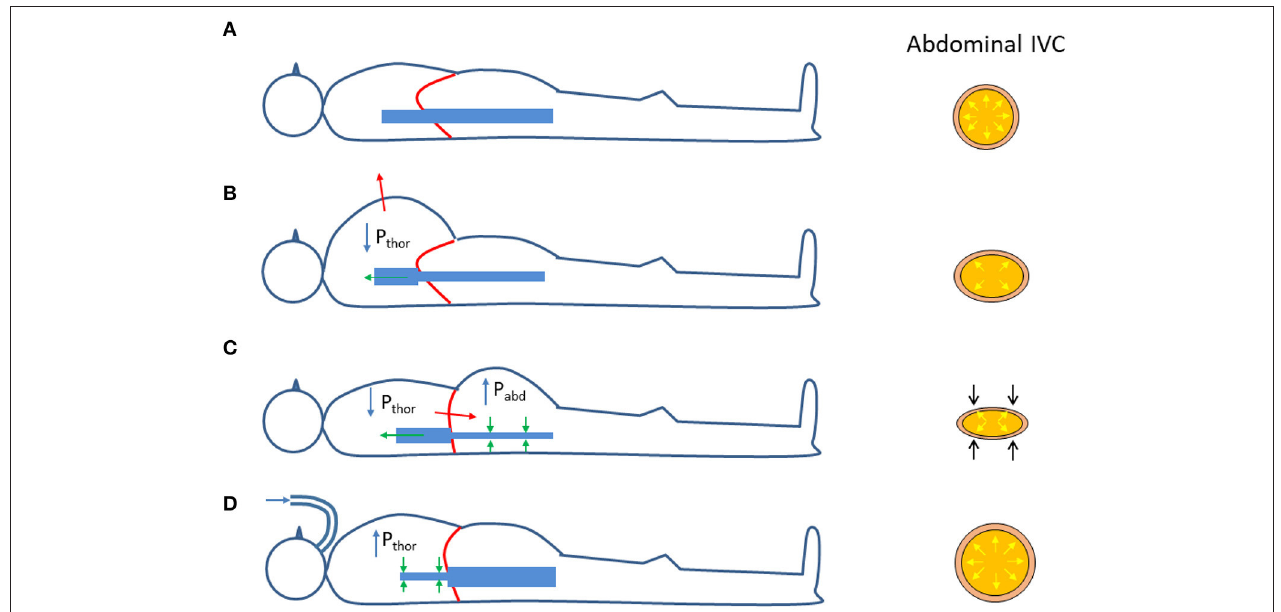
FIGURE 2 | Effects of respiration on the size of the abdominal inferior vena cava (IVC); see explanation in the text. P thor = Intrathoracic pressure; P abd = abdominal pressure. (A) Functional residual capacity (end expiration). (B) Thoracic inspiration. (C) Abdominal (diaphragmatic) inspiration. (D) Positive pressure ventilation